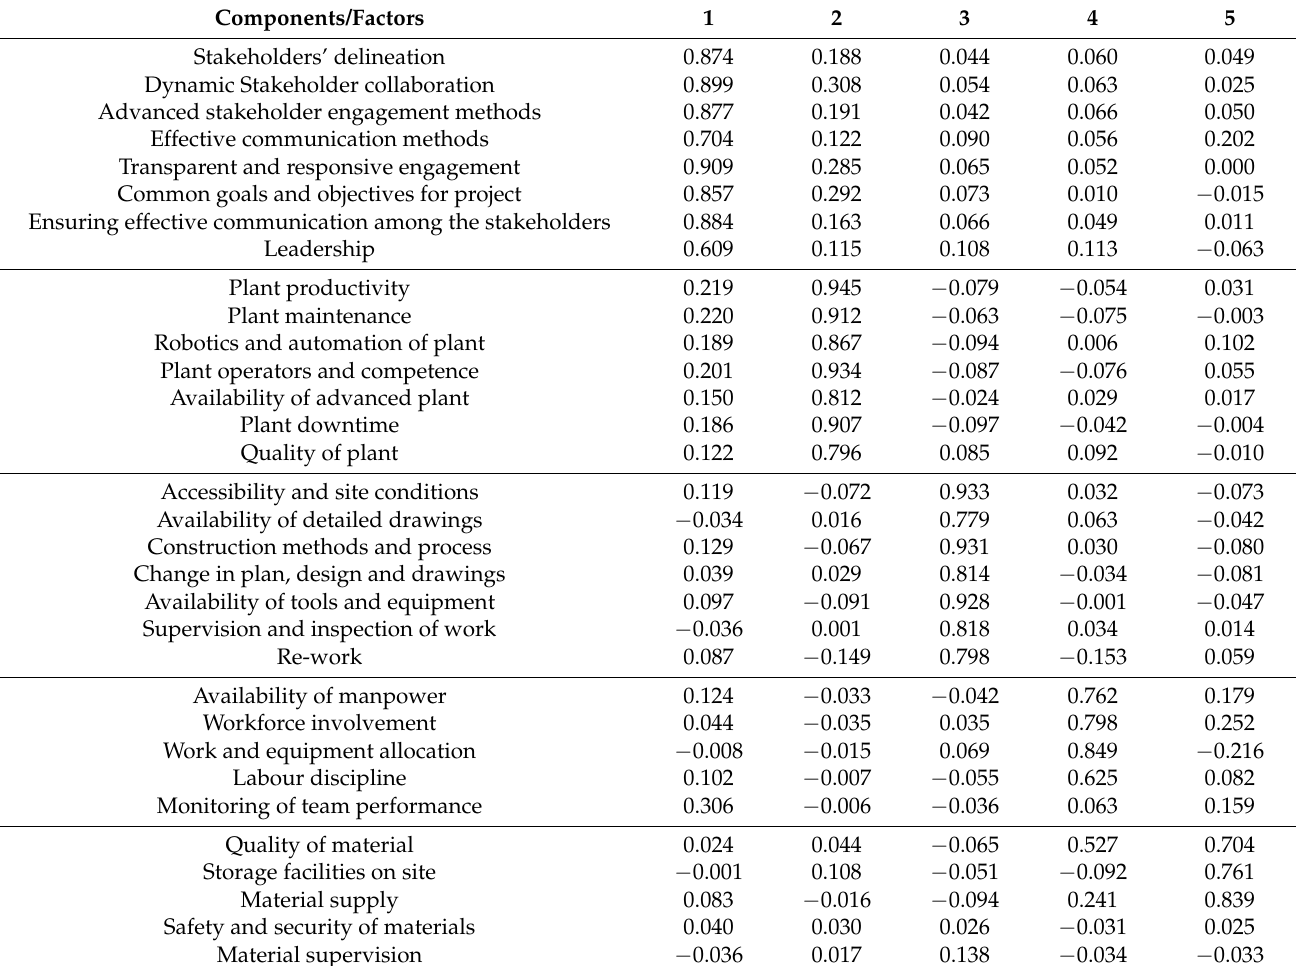
Table 5. Components and factors and their relative impact on the project delivery (Rotated Compo- nent